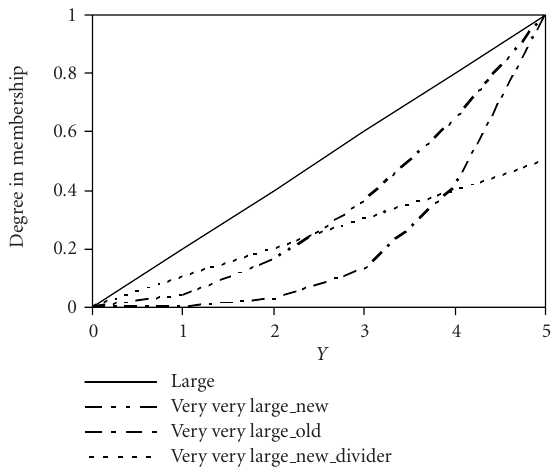
Figure 3.2. Schematic illustration of linguistic hedge “very very.”